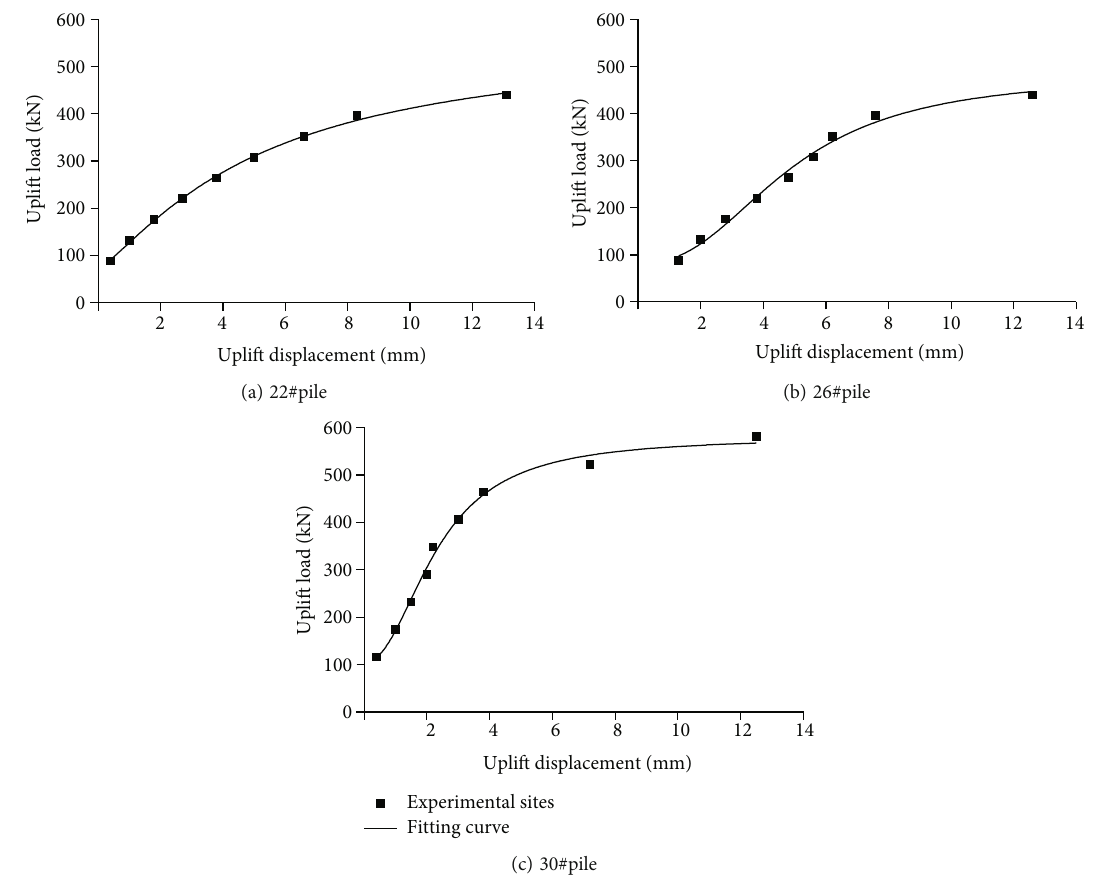
Figure 7: Fitting e ff ect of MMF